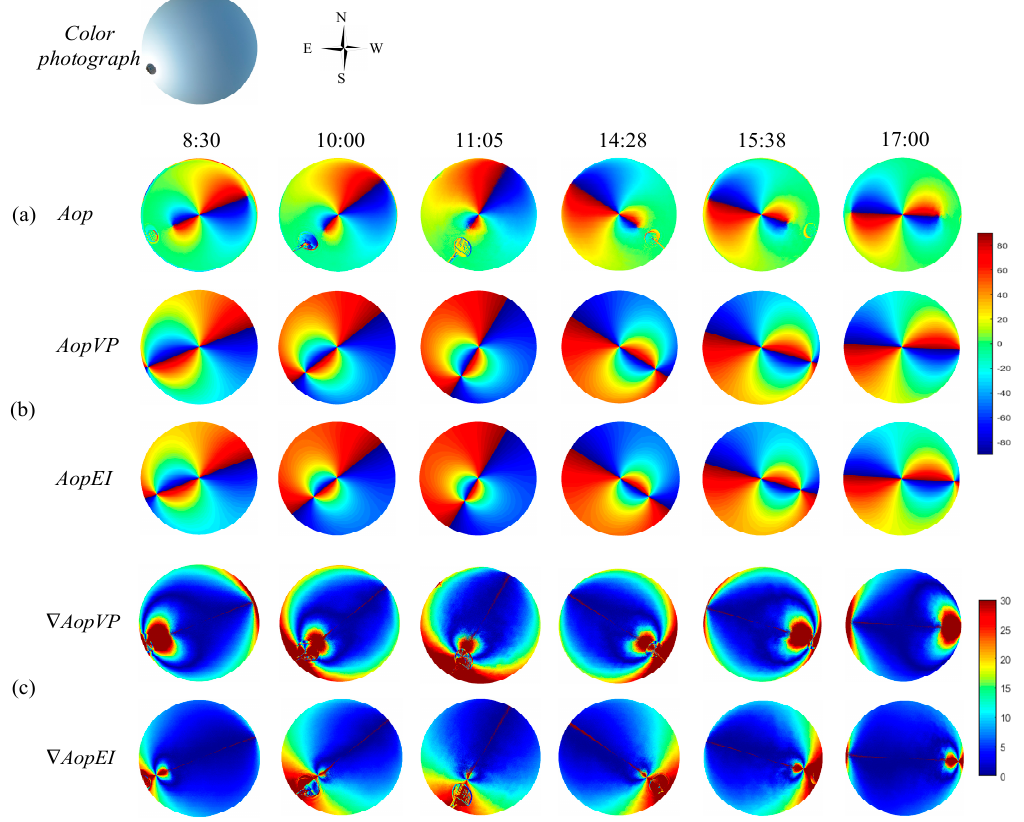
Figure 9. Aop distribution and its consistency representation of the actual measurement, simulation in equidistance imaging mode, and two-dimensional Rayleigh simulation; ( a ) the Aop at each moment obtained by the actual measurement; ( b ) the simulation of AopVP and AopEI , where AopVP represents the two-dimensional simulation of the vertical projection of the Rayleigh model, and AopEI represents the simulation of the equidistance imaging method in the Rayleigh model; ( c ) the consistency of the simulation with the actual measurement; where, ∇ AopVP = (cid:12) AopVP ( i , j ) − Aop ( i , j ) (cid:12) and ∇ AopEI = (cid:12) AopEI ( i , j ) − Aop ( i , j ) (cid:12)